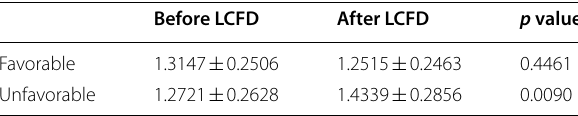
Table 3 Distribution of average σ